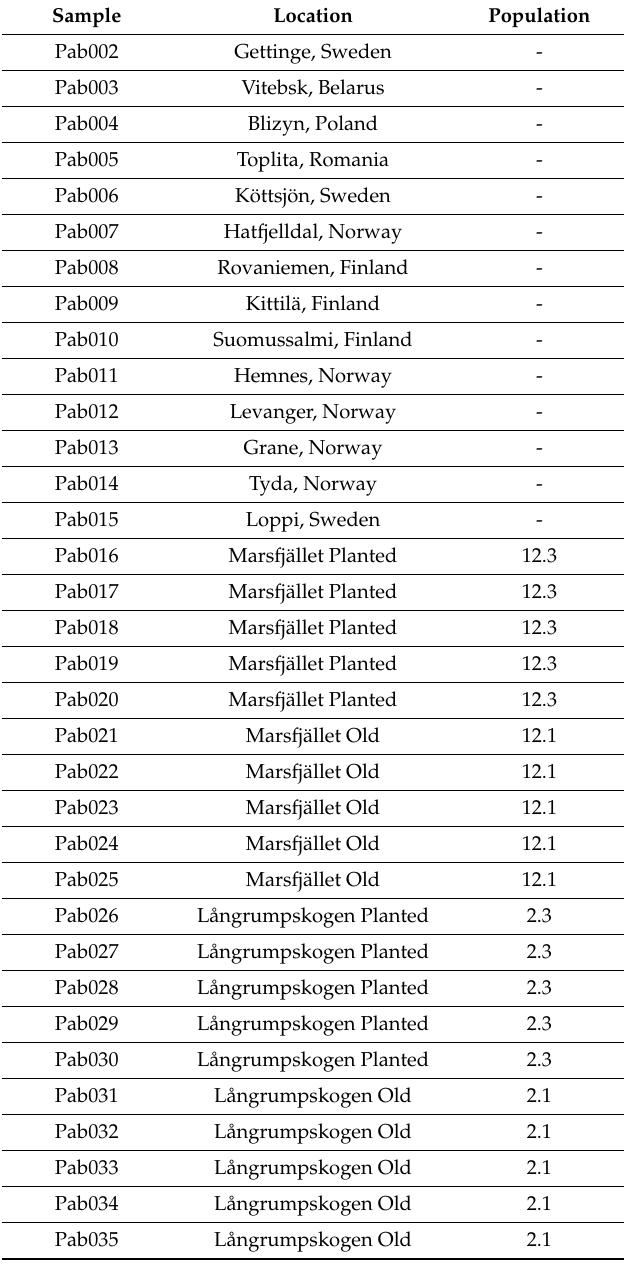
Table 1. Location for all